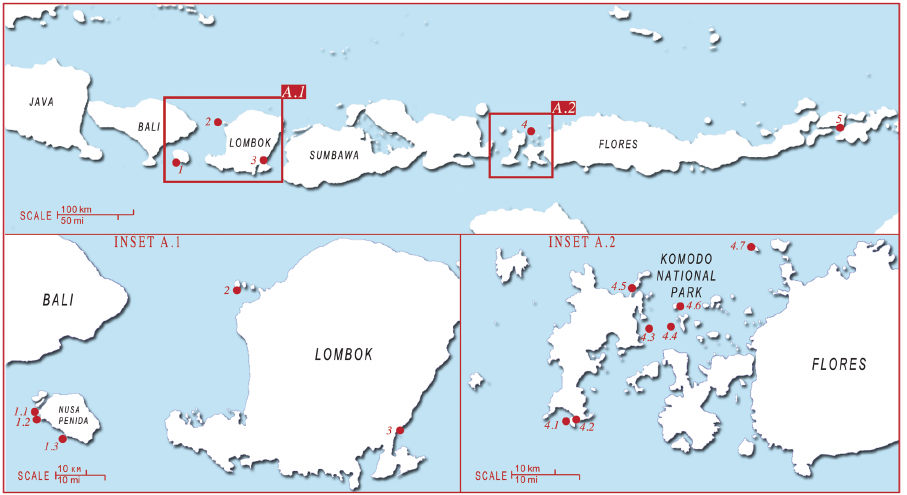
Figure 2. The connectivity area encompassing Nusa Penida, West Manggarai & Komodo regions and the nearby commercial manta ray landing ports. Regions and fishing ports are numbered as follows: 1) Nusa Penida 2) Gili Islands 3) Tunjung Luar fishing port 4) Komodo National Park 5) Lamakera fishing port. (A) Manta ray monitoring sites in Nusa Penida and Lombok and nearby Tujung Luar fishing port: 1.1) Small Manta Bay 1.2) Big Manta Bay 1.3) Manta Point 2) Gili Islands 3) Tanjung Luar fishing port. (B) Manta ray monitoring sites in West Mangarrai and Komodo National Park: 4.1) Manta Alley 4.2) German Flag 4.3) Karang Makassar/Manta Point 4.4) Mawan 4.5) The Cauldron 4.6) Tatawa Besar 4.7) Sabolon